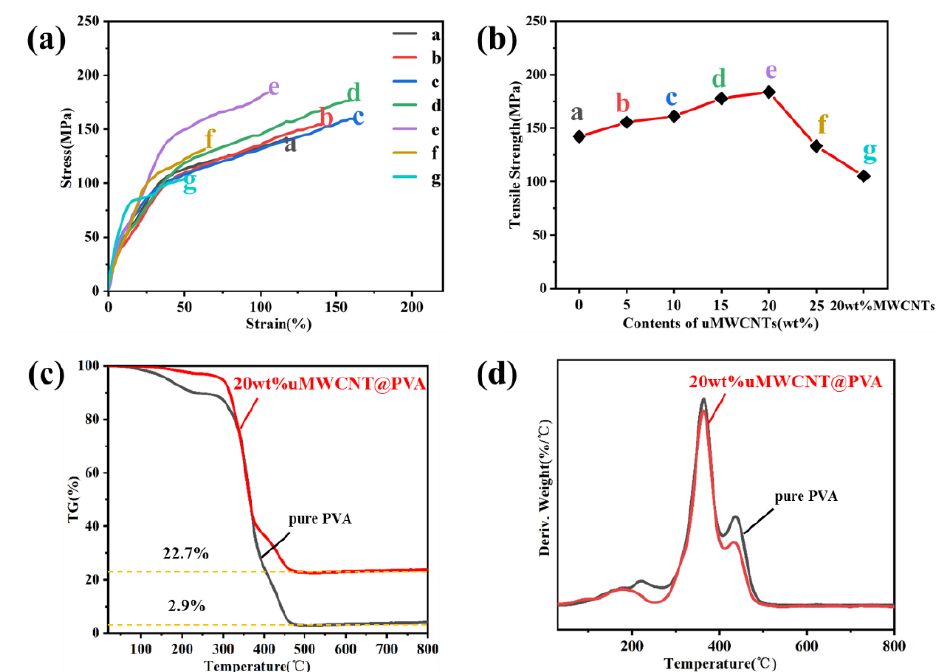
Figure 3. Strain-stress curves ( a ) and tensile strength change trend curve ( b ) of uMWCNT-Fs with different contents of uMWCNTs; TG curves ( c ) and DTG curves ( d ) of pure PVA fiber and 20 wt% uMWCNT-F. The sample names in ( a , b ) are listed in Table 2. Table 2. Tensile strength and strain of uMWCNT-Fs with different contents of uMWCNTs.